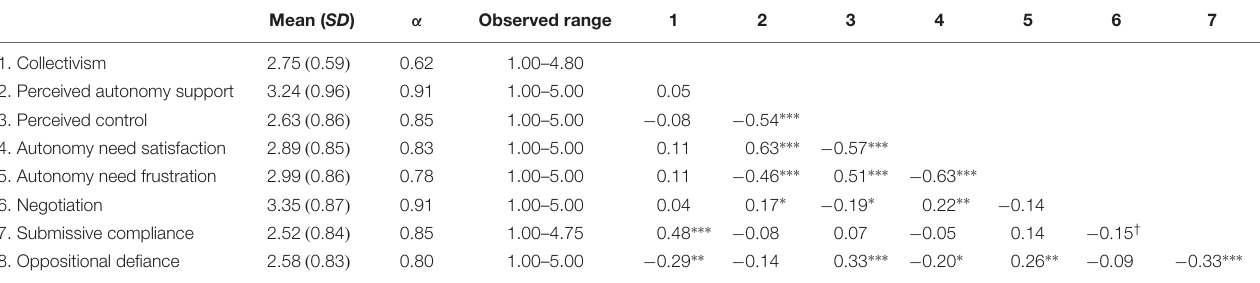
TABLE 1 | Descriptive statistics and correlations between the study variables. Mean ( SD ) α Observed